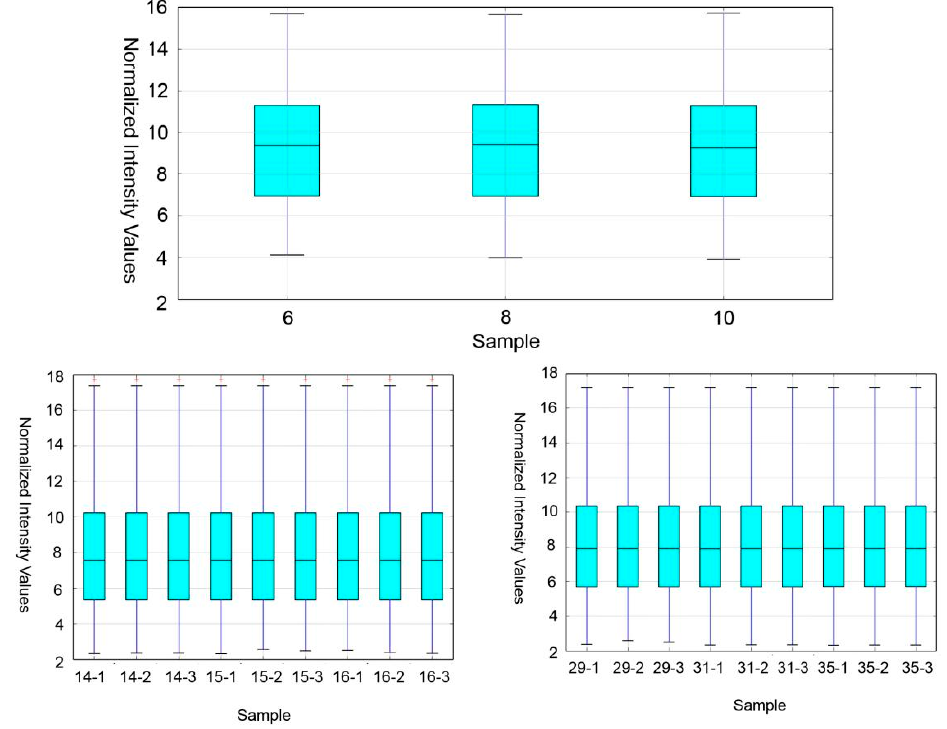
Figure 1. Box plot of normalized intensity values in three phases of spermatogenesis.